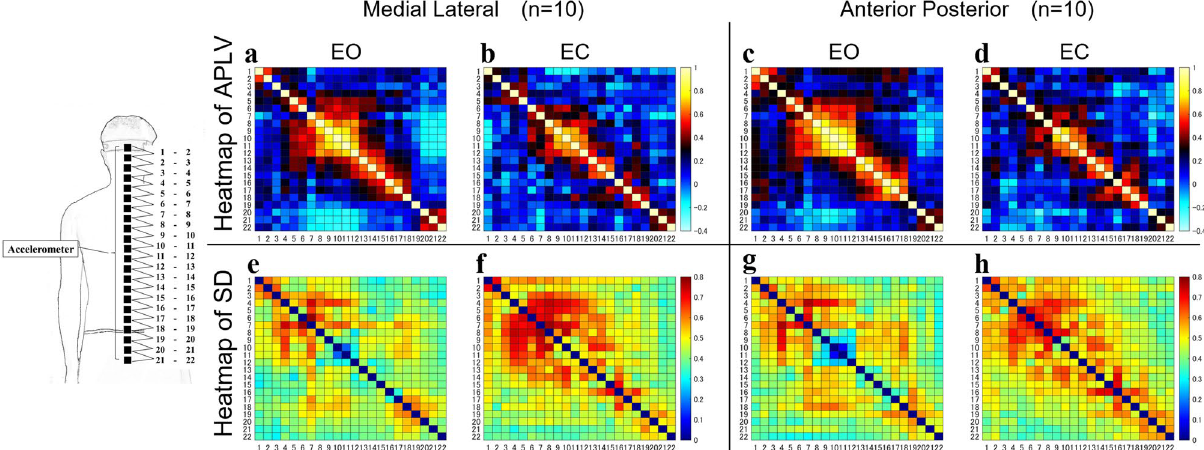
Figure 3. Mean and standard deviation of the instantaneous phase synchronization of acceleration between each sensor. The heat maps of APLV ( a–d ) and SD ( e–h ) are shown for each condition (EO and EC) as phase information in the acceleration time series data. In the heat map of APLV, the left vertical and horizontal axes are the sensor numbers and the right vertical axis is the APLV value. In the heat map of SD, the left vertical and horizontal axes are sensor numbers and the right vertical axis is the standard deviation. APLV: average phase locking value, SD: standard deviation, ML: medial–lateral direction, AP: anterior–posterior direction, EO: eye- opening condition, EC: eye-closing condition.